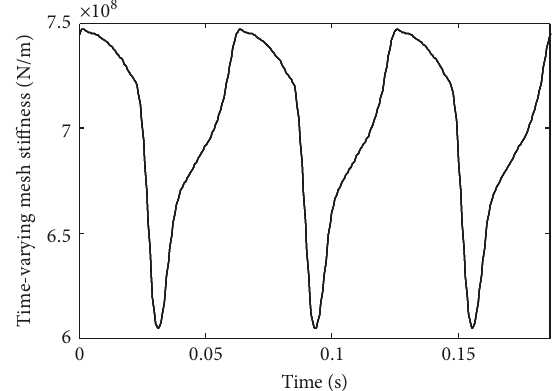
Figure 7: Time-varying mesh stiffness of gear pair at low speed (50.8 rpm) (the time-varying mesh stiffness at high speed (2104r/min) is identical to that in this figure).